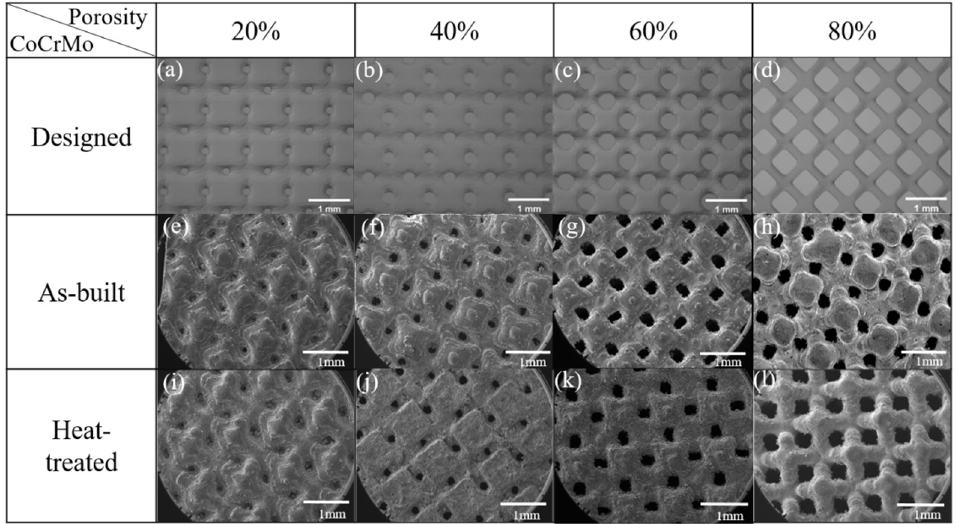
Figure 3. Top-view surface in ( a – d ) CAD-designed models, ( e – h ) as-built, and ( i – l ) heat-treated CoCrMo alloys with different, designed volume porosities.